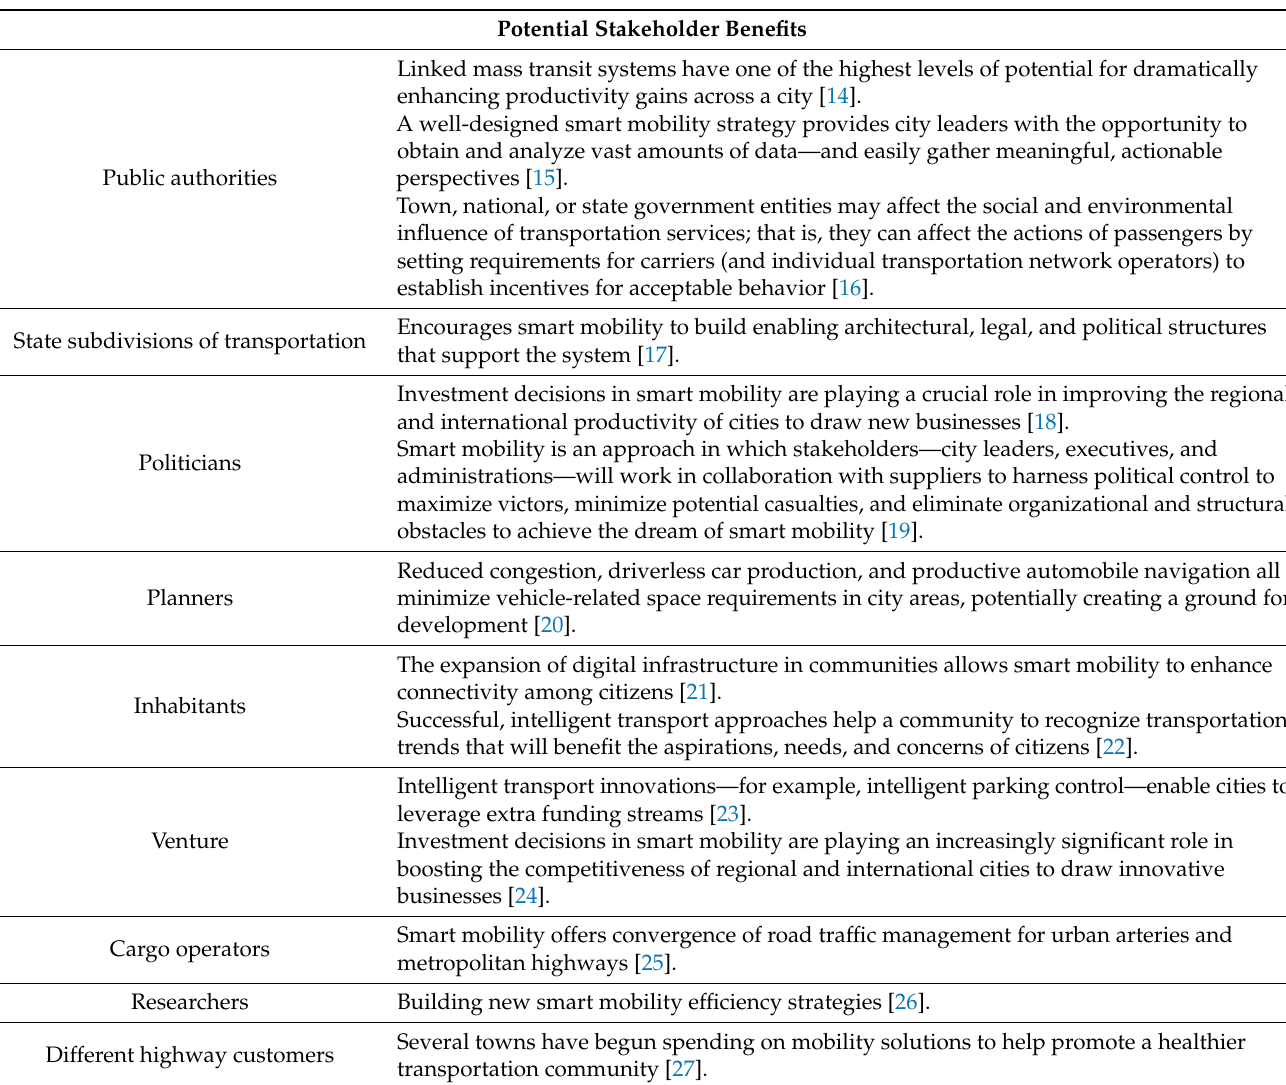
Table 3. Potential benefits of smart mobility for different